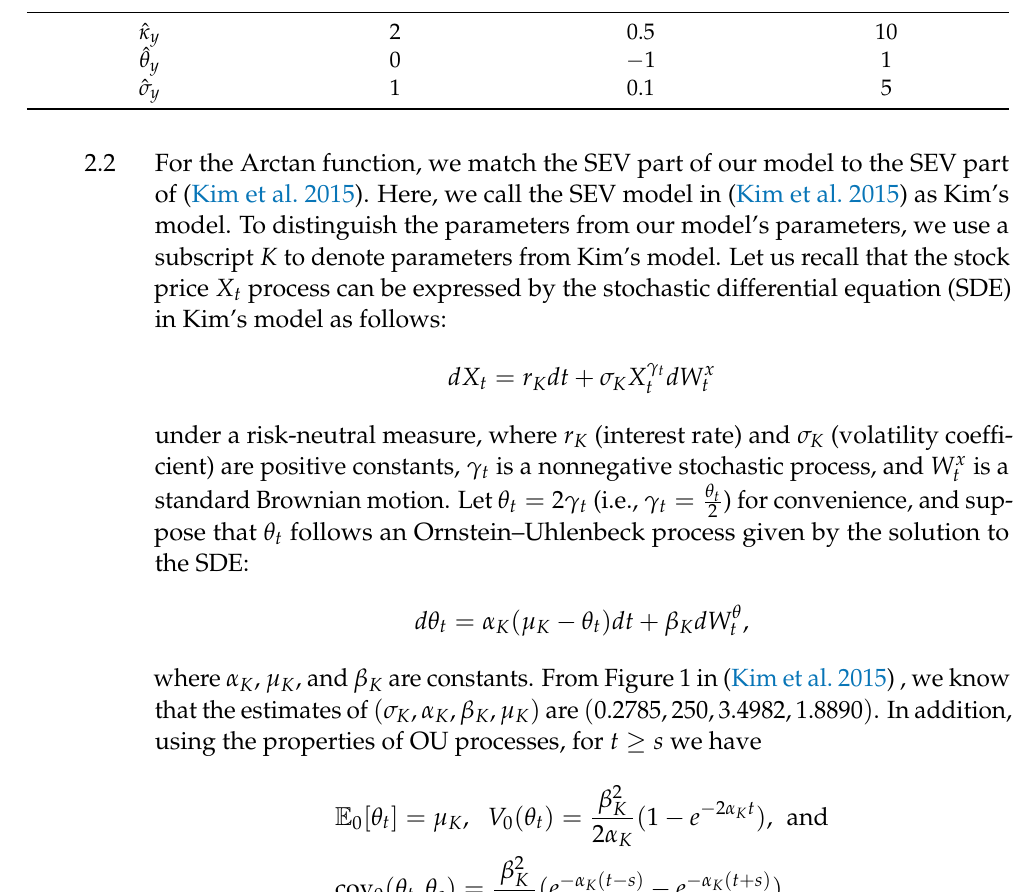
Table 2. Estimation from the properties of the elasticity β t with the SEV-4/2 model.